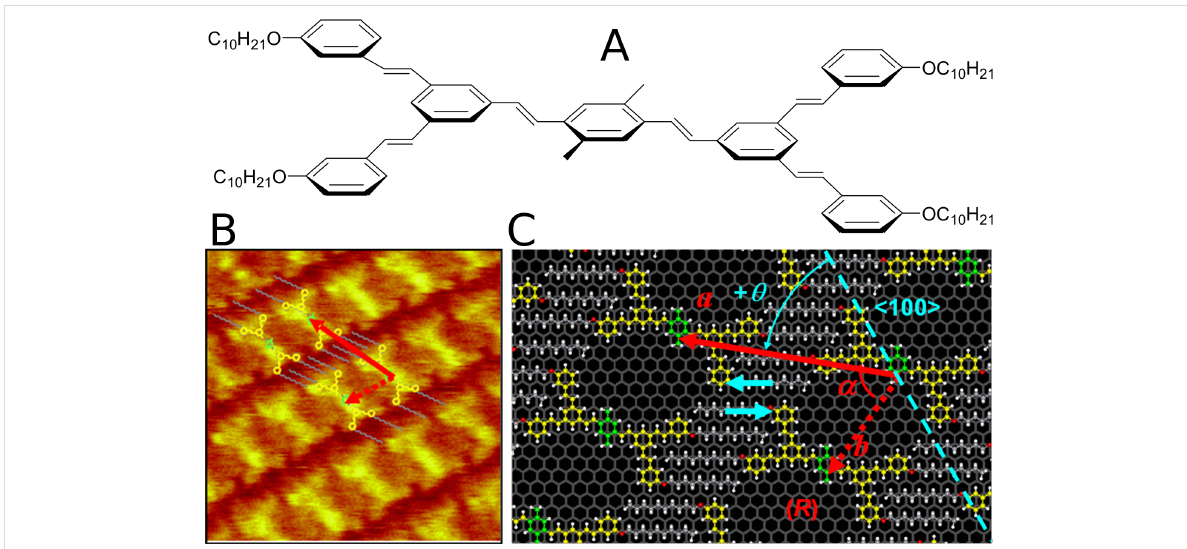
Figure 3: Compound IV: (A) molecular structure and (B) self-assembly of IV demonstrated by a high-resolution STM image of a monolayer domain of (IV) formed at the interface between graphite HOPG and a highly diluted ( ≈ 10 − 4 mol ∙ L − 1 ) solution in phenyloctane. The sample bias was ≈− 1.55 V and the tunnel current was ≈ 55 pA. The scan size and z -scale were ≈ 12.5 nm and ≈ 2.0 Å, respectively. The to-scale model of the molecular assembly is superimposed. (C) Molecular scheme of one unit cell of the monolayer adsorbed on HOPG (grey honeycomb background) of IV. Grey: alkyl chains; Yellow: conjugated cores; Green: multiple cyclophane levels. The unit cell is represented using red arrows: the solid arrow represents the intrachain period and the dotted arrow represents an interchain period. The blue line represents one <100> axis of HOPG. Figure adapted with permission from [28], copyright 2008 Wiley-VCH Verlag GmbH & Co.